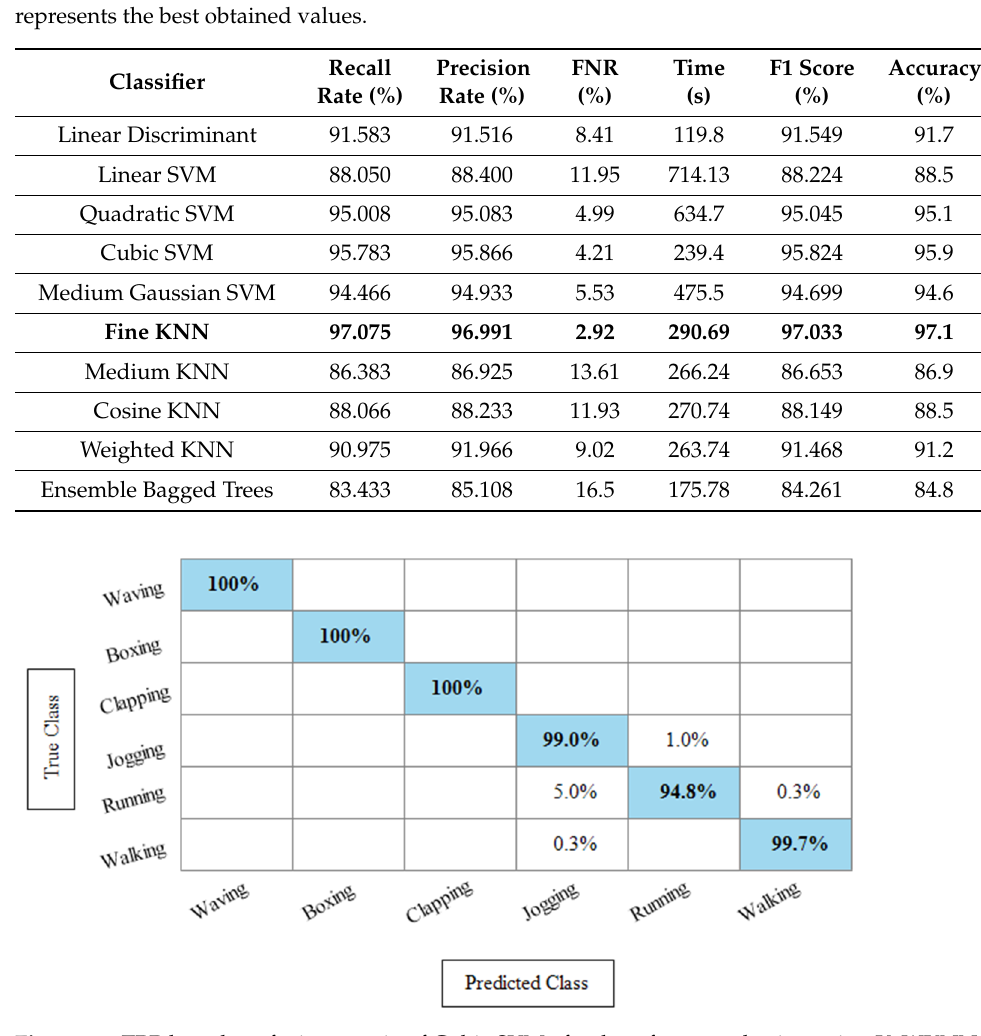
Figure 12. TPR based confusion matrix of Cubic SVM after best feature selection using KcWKNN.